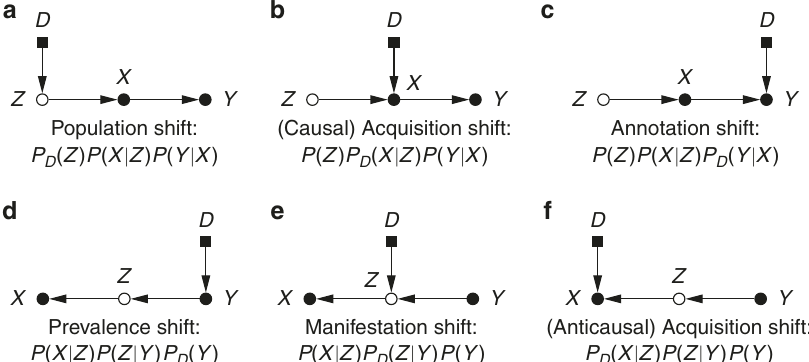
Fig. 3 Selection diagrams for dataset shift. a – c Causal and d – f anticausal scenarios, with corresponding factorisations of the joint distribution P D ( X , Y , Z ). X is the acquired image; Y , the prediction target; Z , the unobserved true anatomy; and D , the domain indicator (0: ‘ train ’ , 1: ‘ test ’ ). An un fi lled node means the variable is unmeasured.